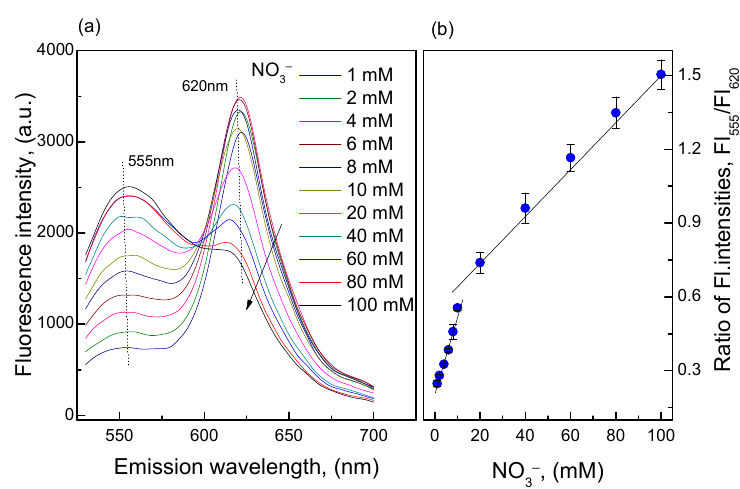
Figure 2 . ( a ) Fluorescence emission spectra of the O17-EC membrane when exposed to ammonia produced from the reductive reaction of different nitrate concentrations in the range of 1–100 mM; ( b ) Calibration curve of the O17-EC membrane in the nitrate concentration range of 1–100 mM.